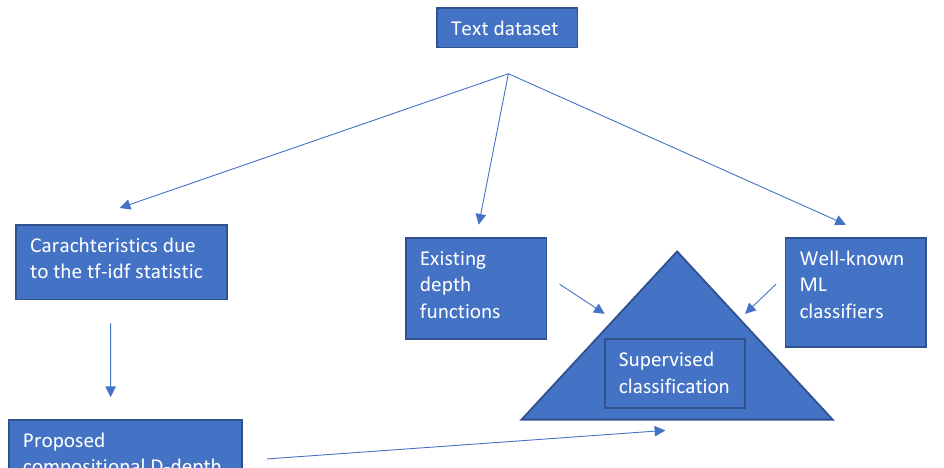
Figure 1. Block diagram representing the steps followed to obtain and validate the proposed depth function designed for text